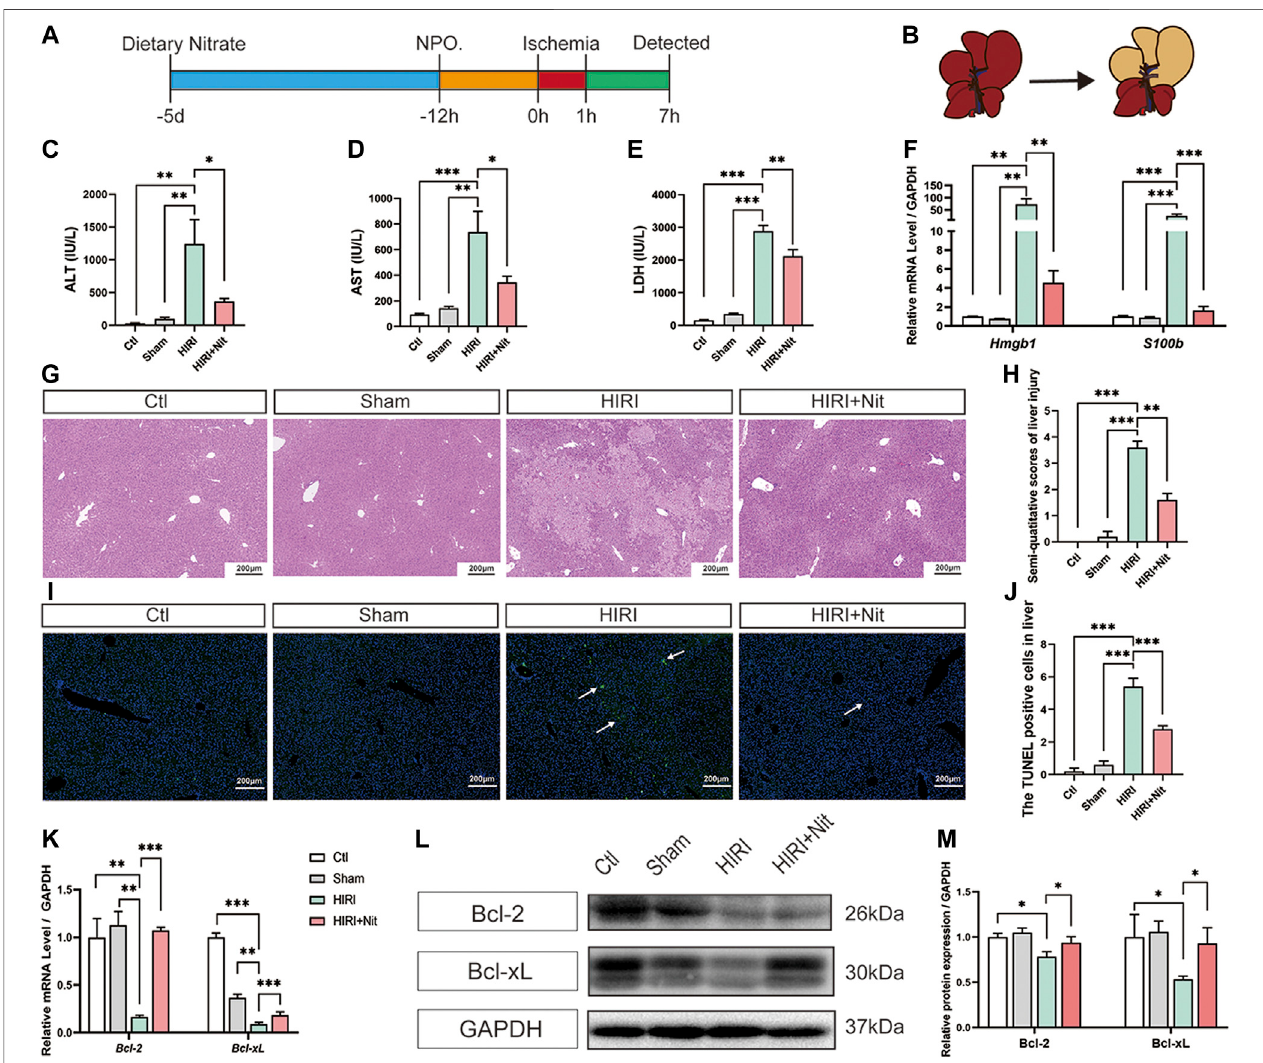
FIGURE 1 | Dietary nitrate prevented hepatic ischemia-reperfusion injury in mice. (A) Model of hepatic ischemia in which dietary nitrate was administered 5 days before operation ( n (cid:2) 5/group). (B) A ventral view of clamping the portal vein and hepatic artery to induce ischemia in the left lateral and median lobes of the liver. plasma activitiesof (C) ALT, (D) AST,and (E) LDH. (F) Relative mRNAexpression of Hmgb1 and S100b . (G) Histological changes(hematoxylinand eosinstaining)ofCtl, Sham, HIRI,andHIRI+Nitgroupsat100 × magni fi cation. (H) Semiquantitativescoreofhistologicalstudy. (I) TUNELassayoftheCtl,Sham,HIRI,andHIRI+Nitgroupsat 100 × magni fi cation. (J) QuantitativescoreofTUNELassay. (K) RelativemRNAlevelsof Bcl-2 and Bcl-xL. (L) WesternblotanalysisofBcl-2andBcl-xLand (M) statistical analyses. Data are expressed as mean ± SEM, *p ＜ 0.05, **p ＜ 0.01, ***p ＜ 0.001, and NS denotes no signi fi cance.